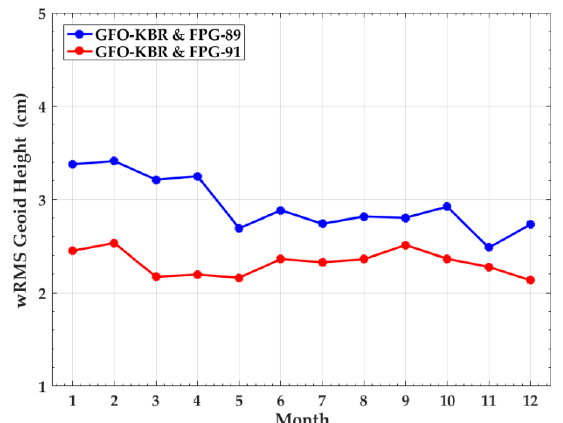
Remote Sens. 2019 , 11 FOR PEER REVIEW Figure 7. Monthly latitude-weighted root mean square (wRMS) of global spatial differences plots (SDP) for GFO-KBR & FPG-89 and GFO-KBR & FPG-91 in 2006. On a global scale, results in April and October are plotted in the left and right columns of Figure 8, respectively. Subfigures in the top row represent the spatial signal plots of monthly true C S C S Δ Δ = in HIS signals, which are created the same way as SDP except that the ( , ) ( , ) HIS HIS lm lm lm lm Equation (14); The middle and bottom rows represent SDPs of GFO-KBR & FPG-89 and GFO-KBR & FPG-91, respectively. As shown, the GFO-KBR & FPG-91 apparently suffers less from the temporal aliasing errors, especially in low- and medium-latitude areas. The error reductions in these areas are beneficial to the scientific study of global water cycle since the world’s major river basins (e.g., the Amazon and Yangtze Rivers), as well as the majority of oceans, are located in the low and medium latitudes.